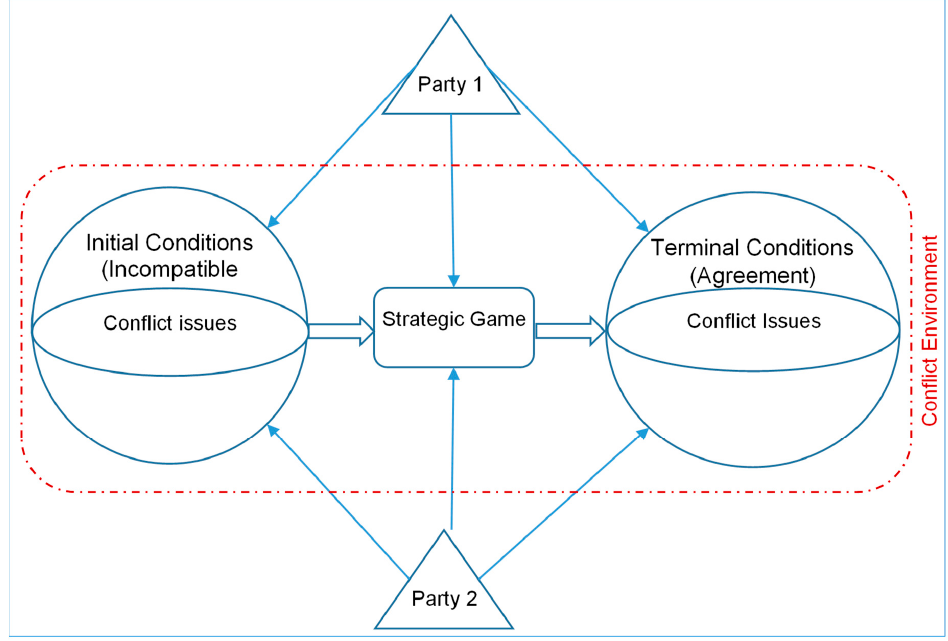
Figure 7. Structure of Institution-constrained Game